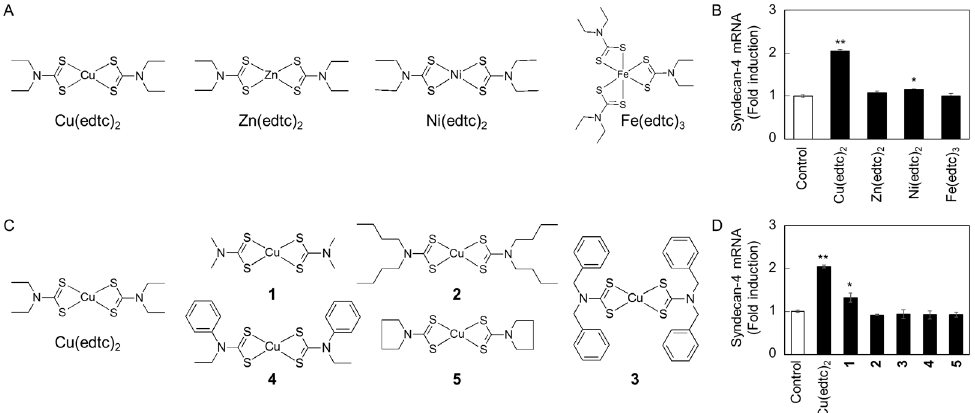
Figure 4. Role of copper and EDTC in the Cu(edtc) 2 molecule in syndecan-4 mRNA induction in vascular endothelial cells. ( A ) Structure of Cu(edtc) 2 , Zn(edtc) 2 , Ni(edtc) 2 , and Fe(edtc) 3 ; ( B ) expression of syndecan-4 mRNA. The cells were incubated at 37 ◦ C for 8 h in the presence of Cu(edtc) 2 , Zn(edtc) 2 , Ni(edtc) 2 , or Fe(edtc) 3 (3 µ M each), then syndecan-4 mRNA levels were measured by RT-PCR; ( C ) structure of Cu(edtc) 2 , and copper complexes 1 – 5 ; ( D ) expression of syndecan-4 mRNA. The cells were incubated at 37 ◦ C for 8 h in the presence of copper complexes (3 µ M each), then syndecan-4 mRNA levels were measured by RT-PCR. Values are means ± S.E. of four replicates. * p < 0.05; ** p < 0.01 vs. control.